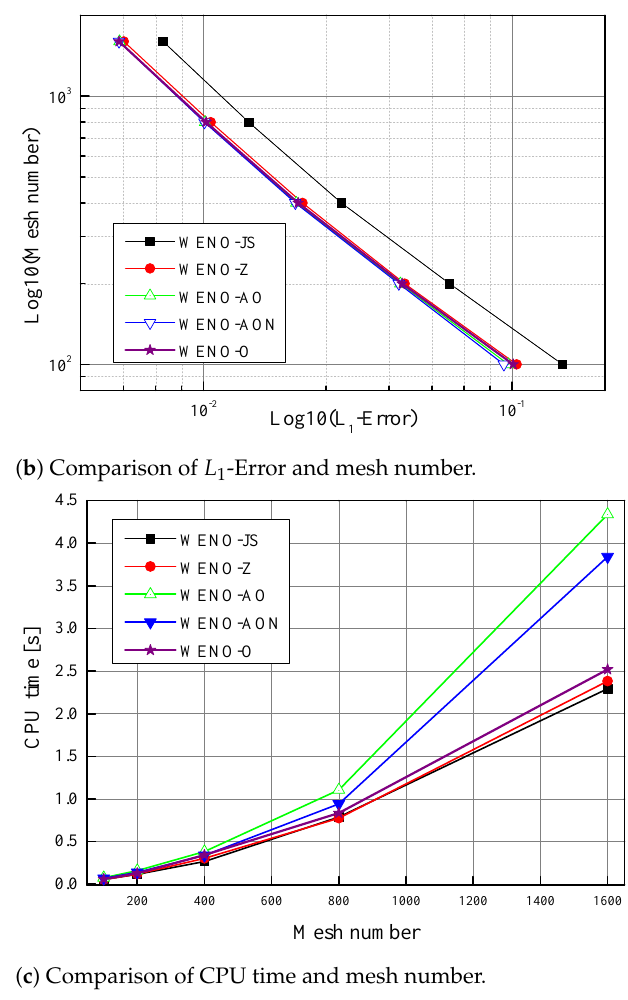
Figure 7. The accuracy comparison of WENO-O with WENO-AO, WENO-AON, WENO-Z, and WENO-JS schemes for Example 3 (Section 6.1.3) on 1600 cells at t = 10 and CFL = 0.1.